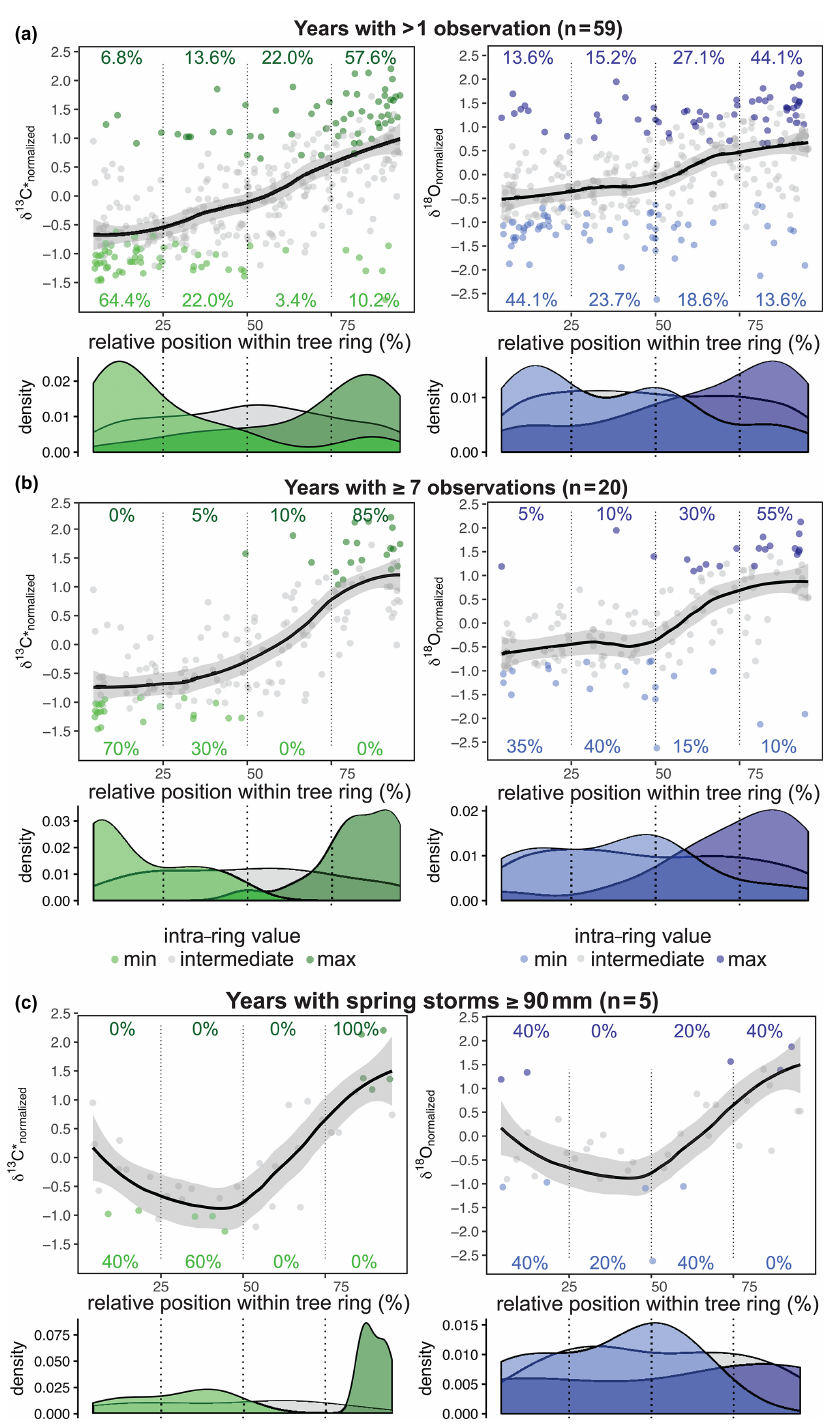
Figure 5. Relative position of normalized δ 13 C ∗ (green) and δ 18 O (blue) values (a–c) . Smooth line illustrates the intra-annual course of the isotope ratios with the standard error as the grey shaded area (loess fit with span = 0.6). (a) For both δ 13 C ∗ and δ 18 O the first half of the tree ring is dominated by minimum values and the second half by maximum values. (b) The common isotopic pattern becomes clearer for tree rings with seven or more samples. δ 13 C ∗ shows a gentle increase during the first two quarters and then increases strongly before leveling off in the last quarter. δ 18 O is characterized by a dip in the mid-section before the steep rise of the values. (c) For years with spring cyclones with ≥ 90mm of rain (i.e., 1959, 1963, 1977, 1989, 2002) and five or more isotope values per year, δ 13 C ∗ shows decreasing values within the first half of the tree ring and a steep increase in the second half. The δ 18 O values show their minimum around the center of the tree ring, followed by a steep rise towards the end of the tree